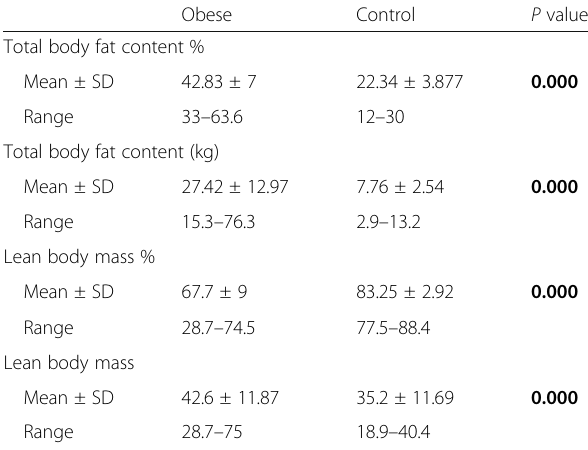
Table 3 Comparison of skeletal age difference between obese and control